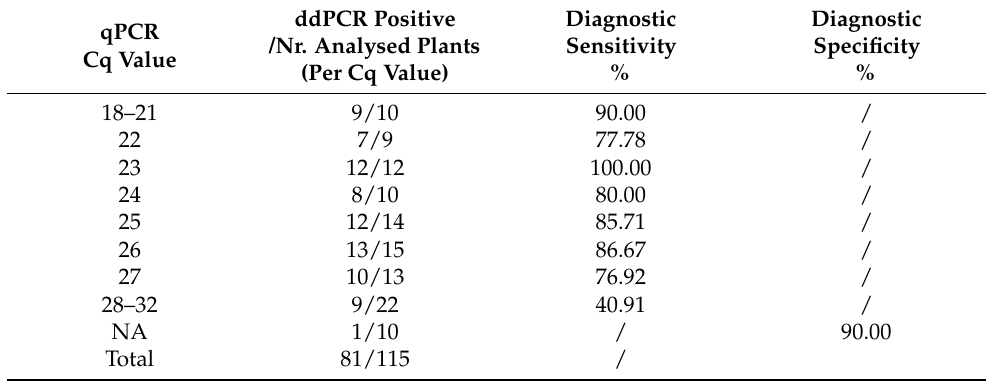
Table 2. Comparison of ddPCR and qPCR assays for the Xfp detection in a subset of 115 olive samples. Number of plants testing positive and negative in ddPCR and diagnostic parameters of the assay are reported. The samples are grouped per each Cq